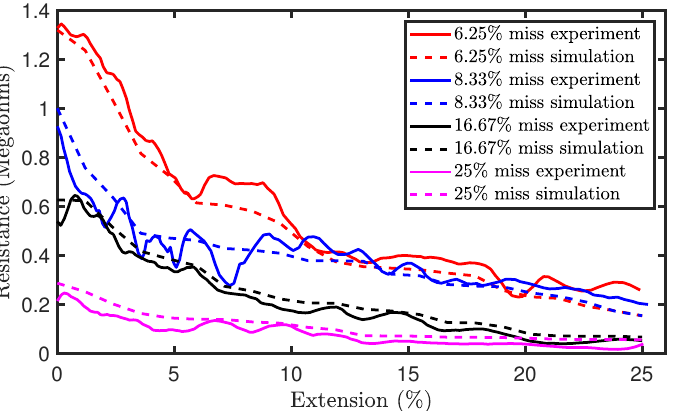
Figure 14. Comparison of simulation and experimental results for sensors with miss stitches.